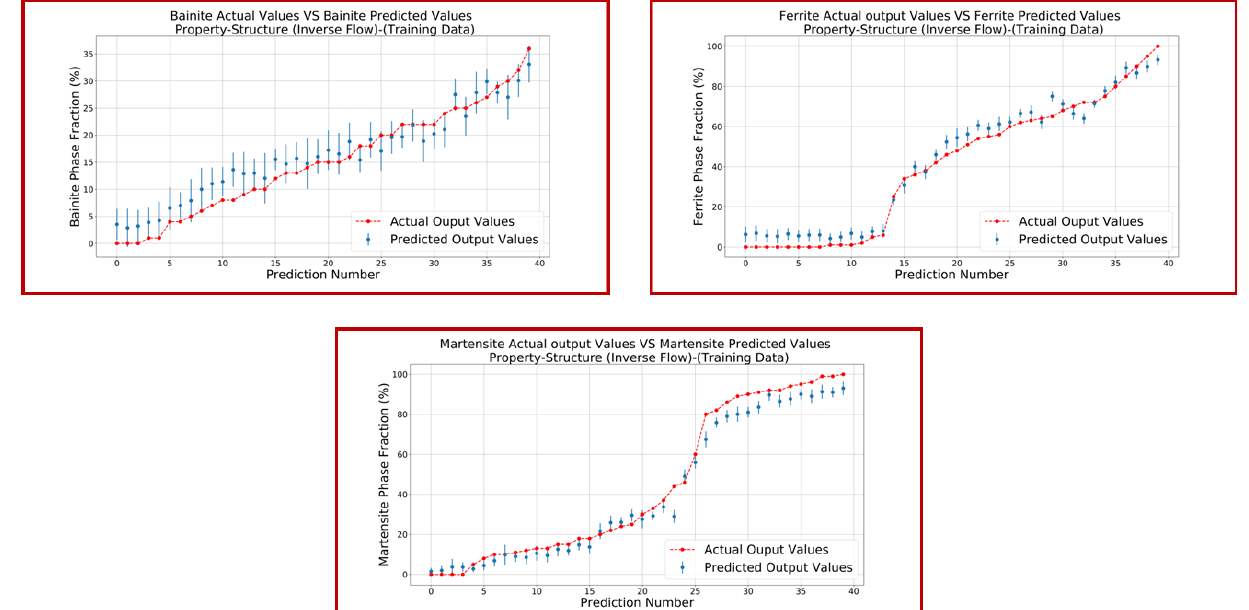
Figure 7. Predicted Output and Actual Output Comparison for Step 2 (For Input Dataset).